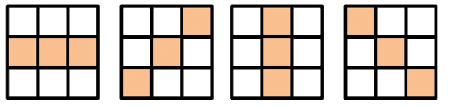
Figure 2. Multi-window Directions